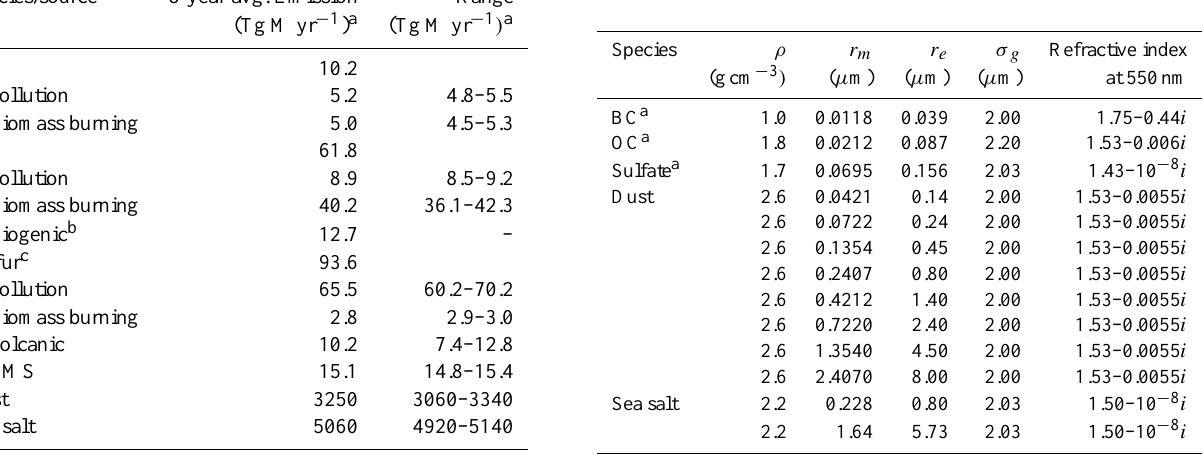
Table 2. Particle density ( ρ ), modal and effective radii ( r m and r e ) , geometric standard deviation ( σ g ) in lognormal size distribution, and refractive indices at 550nm for dry